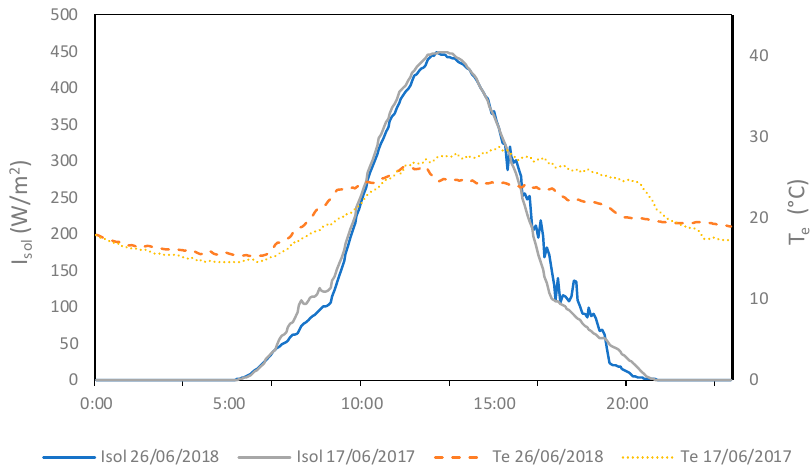
Figure 6. Comparison of environmental conditions for the two days analyzed.